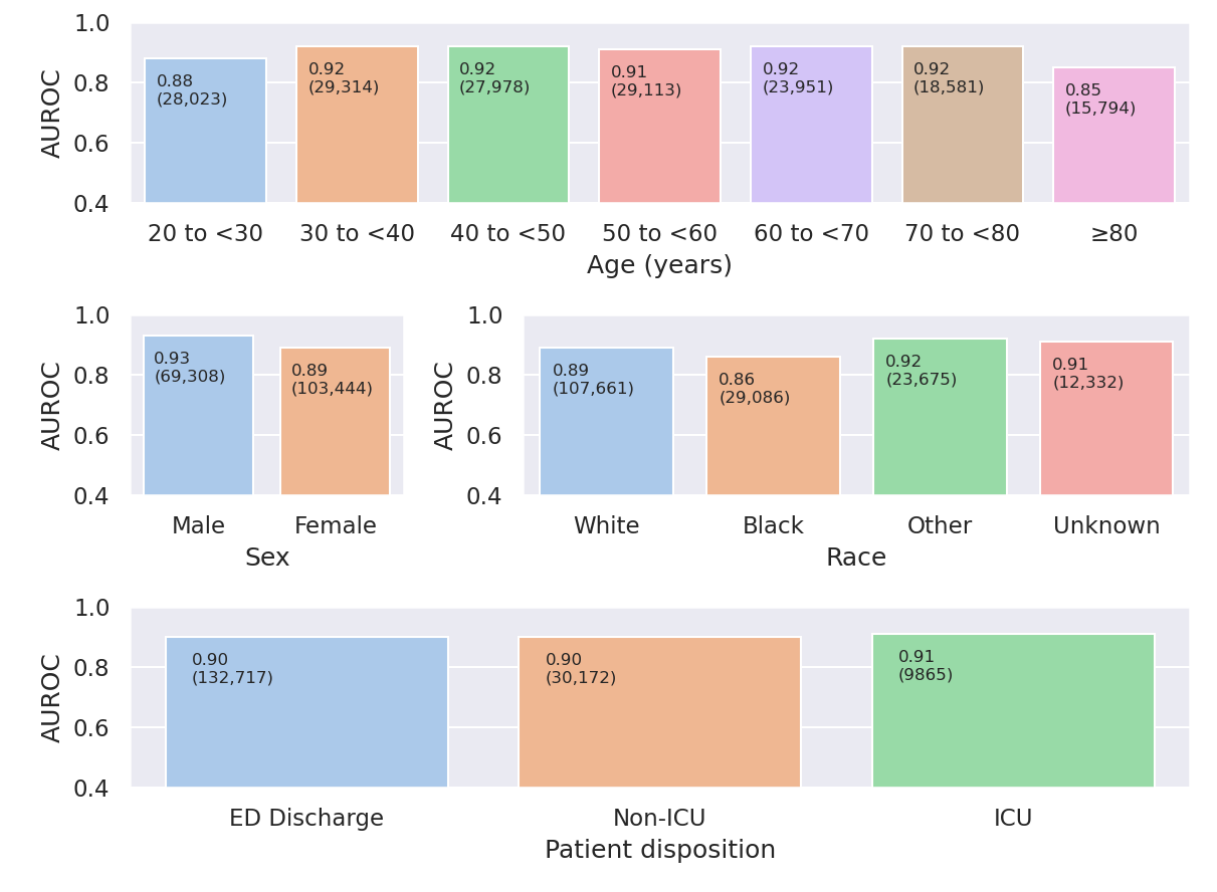
Figure 2. Discrimination as assessed by AUROC curve in age, sex, race, and ED disposition subgroups in the external validation data set. Non-ICU patients were admitted to the hospital but not to an ICU. Distribution of AUROC curves per demographic, as well as per patient disposition type (ED discharge, non-ICU, and ICU) in the external validation data set. Top numbers are AUROC curves, bottom numbers in parentheses are the number of patients. AUROC: area under the receiver operating characteristic; ED: emergency department; ICU: intensive care